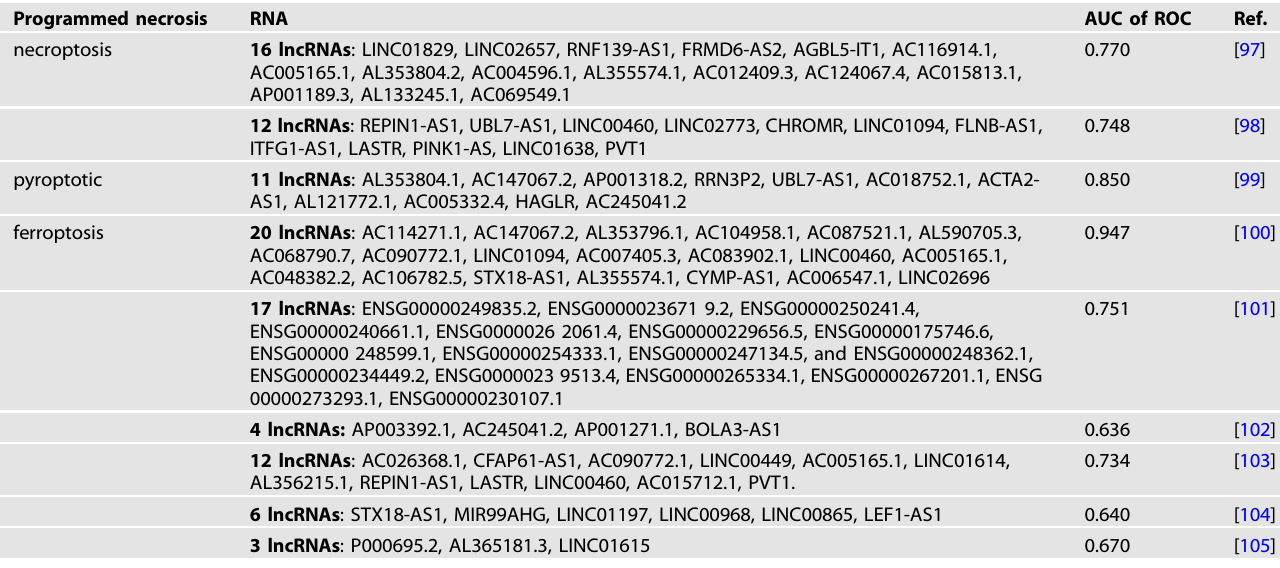
The bold values represent the number of lncRNAs in each gastric cancer prediction